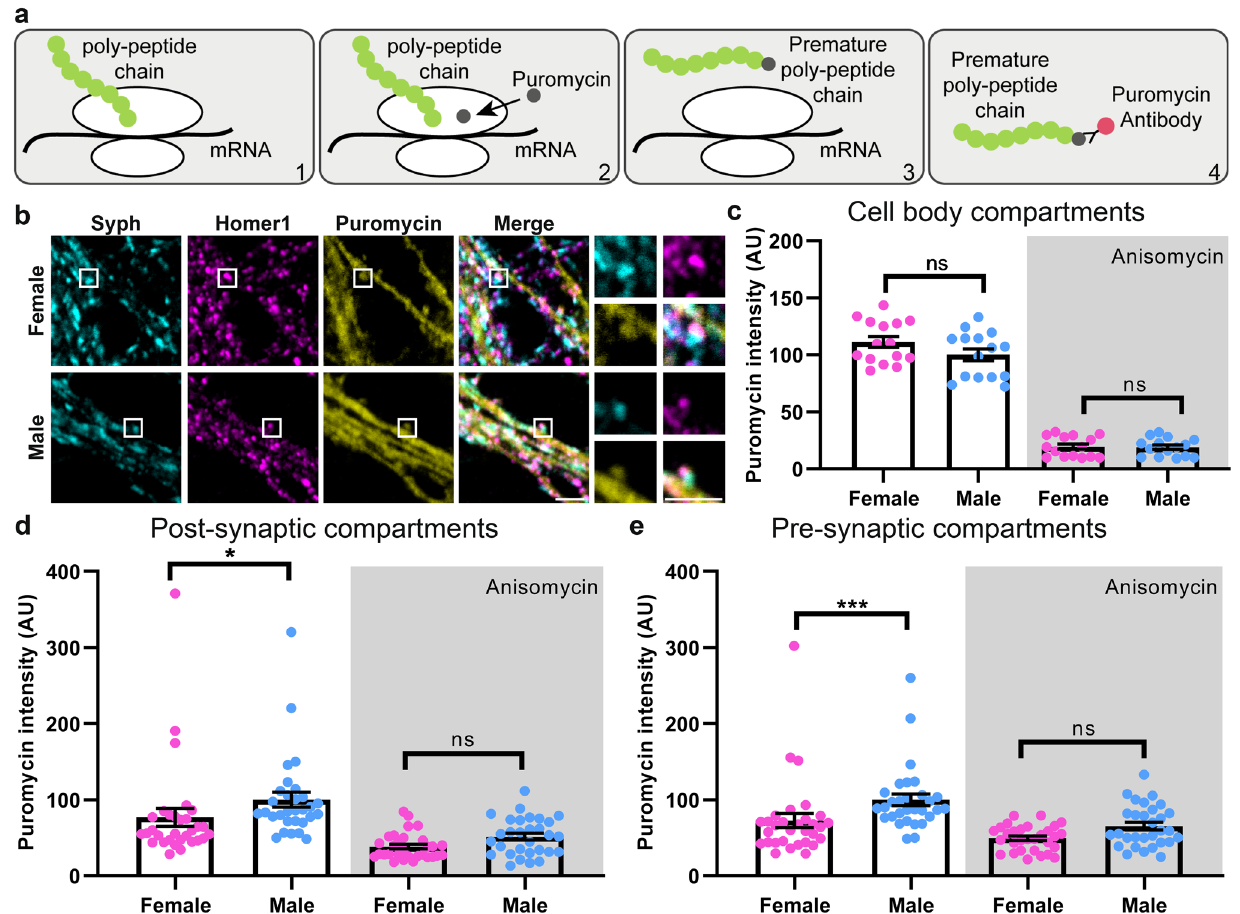
Figure 3. Male hippocampal neurons have a higher synaptic translation rate. ( a ) To report local translation rates, we performed a “puromycin assay”. During translation, the ribosome moves along the mRNA, enabling the growth of the poly-peptide chain (1). Puromycin interferes with the translation by binding to the ribosome, and stops the translation by incorporating itself into the premature polypeptide chain (2). It will release the premature poly-peptide chain (3). An immunostaining against puromycin shows the amount of translation at a certain location (4). To calculate the background of the puromycin treatment, we used another antibiotic, anisomycin, which prevents the incorporation of puromycin to a poly-peptide chain (not shown in the cartoon). ( b ) Exemplary images for the puromycin assay, along with Syph and Homer1 immunostainings, which indicate the pre- and postsynaptic sites. Scale bar: 2.5 µm. ( c ),( d ) and ( e ) The intensity of puromycin staining was measured in the cell body, post- and presynaptic compartments. Dots represent the mean of an image. The bar graphs indicate the mean ± SEM. N = 4 independent experiments, for panel c 5 images and for panels d and e 10 images were taken per condition. The statistical comparison was performed by the Kruskal–Wallis test together with the Dunn’s multiple comparisons test. * p < 0.05, *** p < 0.001. Male neurons show significantly higher translation rate at the synapse, but not in the cell